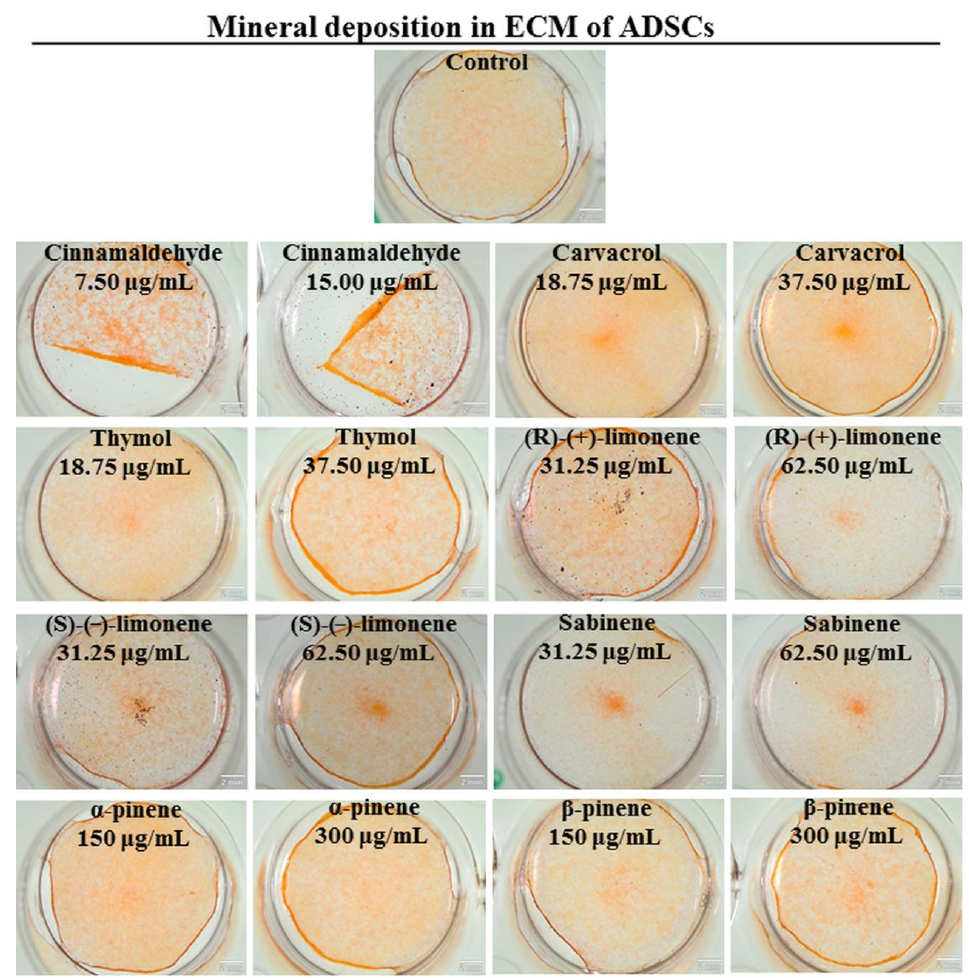
Figure 5. Qualitative evaluation of mineral deposition in the ECM of canine adipose tissue-derived mesenchymal stem cells (ADSCs) assessed by Alizarin Red S staining and followed by stereoscopic microscope visualization (scale bar = 2 mm).